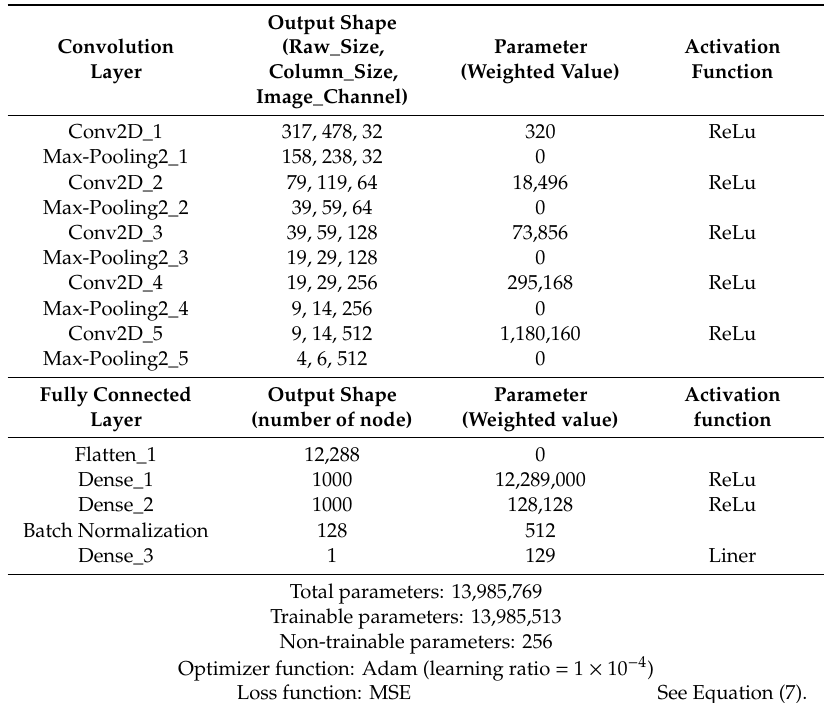
Table 3. Summary of Study